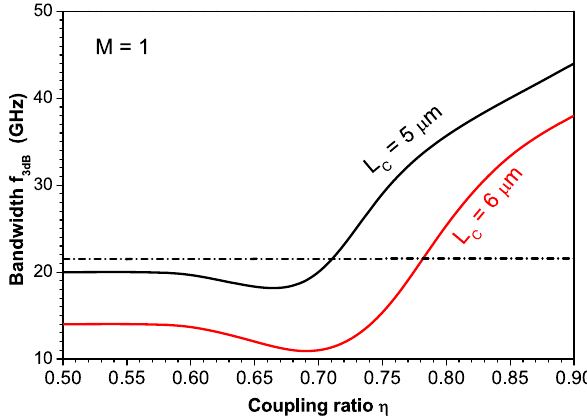
Figure 5: Variation of the bandwidth f 3dB of the TTC VCSEL with the coupling ratio η when L C = 5 and 6 μ m.